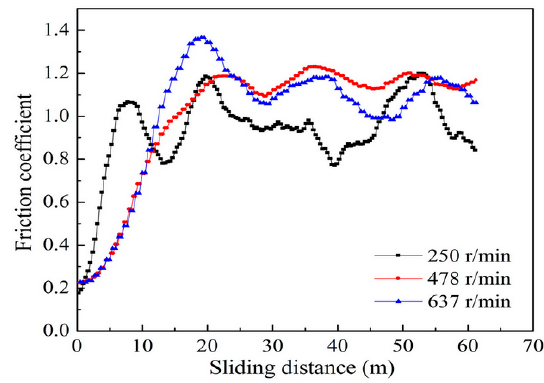
Figure 3. Friction coefficients (FCs) of original samples under different sliding speeds.